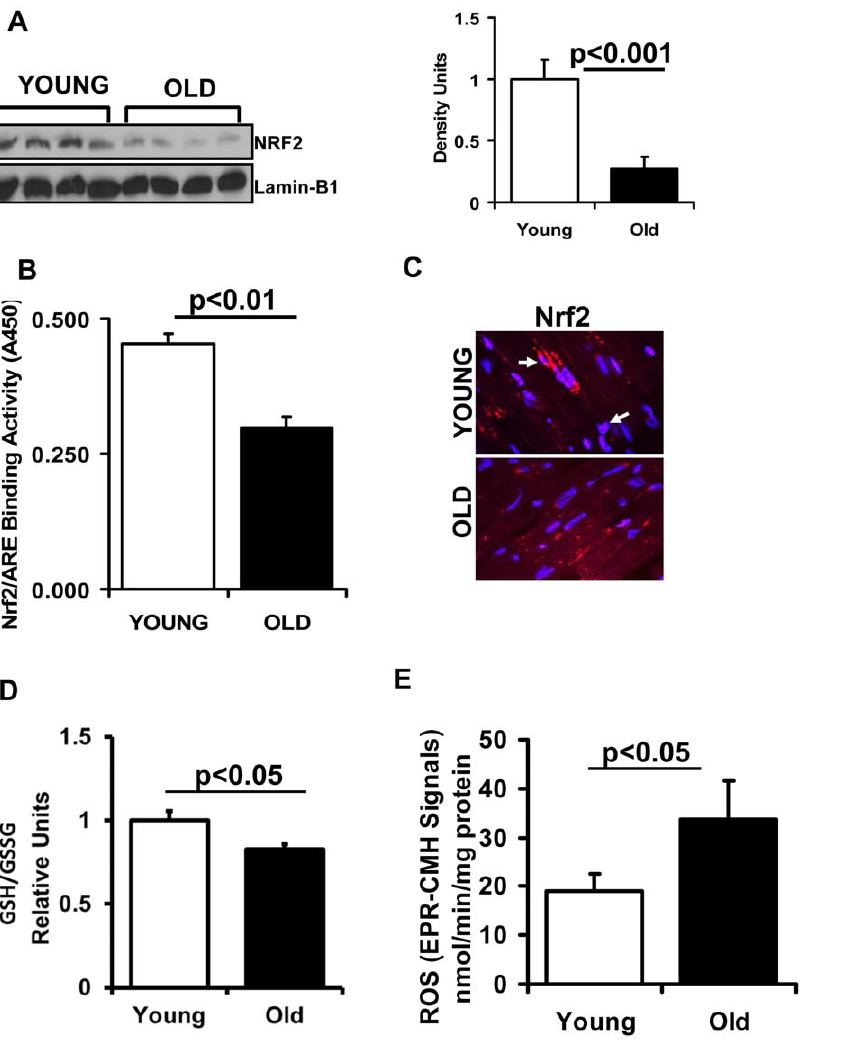
Figure 1. Decreased function of Nrf2 in the aging heart. ( A ) Decreased nuclear translocation of Nrf2 is evident in the heart of aging mice. Representative immunoblot (IB) of nuclear proteins collected from young and aged WT mice (n=6) under basal state. Each lane represents an individual animal/heart. Lamin-B1 used as loading control. Densitometry analysis of the IB images was achieved using Image-J. ( B ) Transcription factor binding (TransAM-Nrf2 activity) assay: Nuclear proteins from young and aged mice (n=4) were incubated with the oligonucleotide (pre- coated on 96 well plate/strips) for ARE (antioxidant response element). ( C ) Localization of Nrf2 by immunofluorescence: Immunofluorescence analysis using anti-Nrf2-ab (1:200; v/v) showing decreased cytosolic and nuclear Nrf2 in old versus young myocardium. Blue: nucleus (DAPI); Red: Nrf2-staining and Pink: merge of blue and red indicating nuclear localization of Nrf2. IF images were obtained at a magnification of 60X oil immersion. ( D ) Glutathione redox-state: Myocardial redox state was determined in the ventricles of 2 and 23 months old mice under basal conditions. Statistically significant changes in the redox ratio (GSH/GSSG) were observed in young and old groups. Values are mean 6 SD for 5 or more animals in each group. ( E ) Increased reactive oxygen species (ROS) generation in the hearts of aging mice: Electron paramagnetic resonance (EPR) spectroscopy signals for CMH (1-hydroxy-3-methoxy-carbonyl-2, 2,5,5- tetramethyl pyrrolidine) in young and aged mice. EPR signals for CMH are significantly increased in aged versus young mouse myocardium. Values represent n=5 or more from each